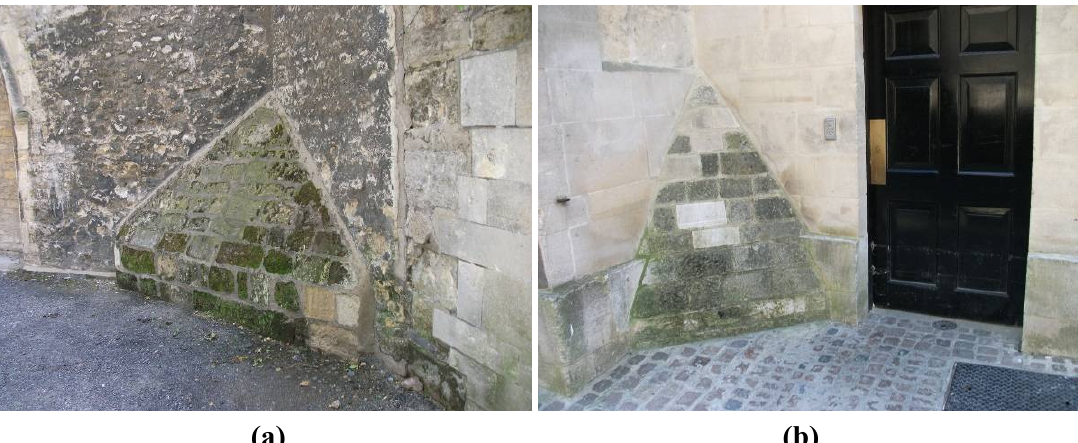
Figure 6. Algal mats growing at similar architectural features on buildings, at ( a ) St Edmund Hall and ( b ) near Queen’s